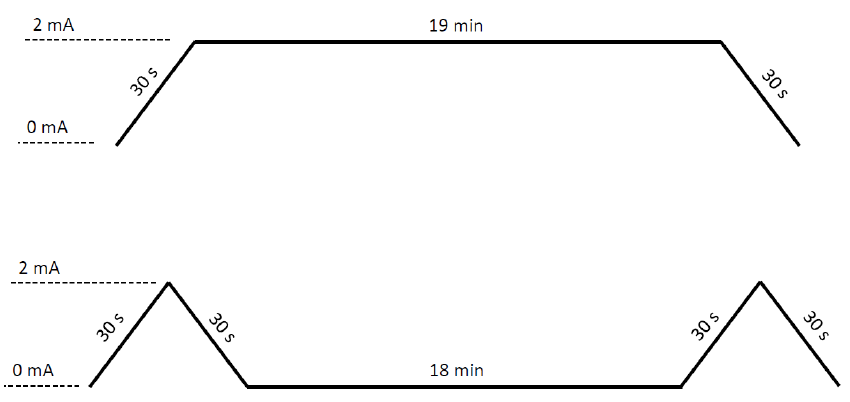
Figure 1. Stimulation protocol. Active tDCS (upper) and sham tDCS (lower).